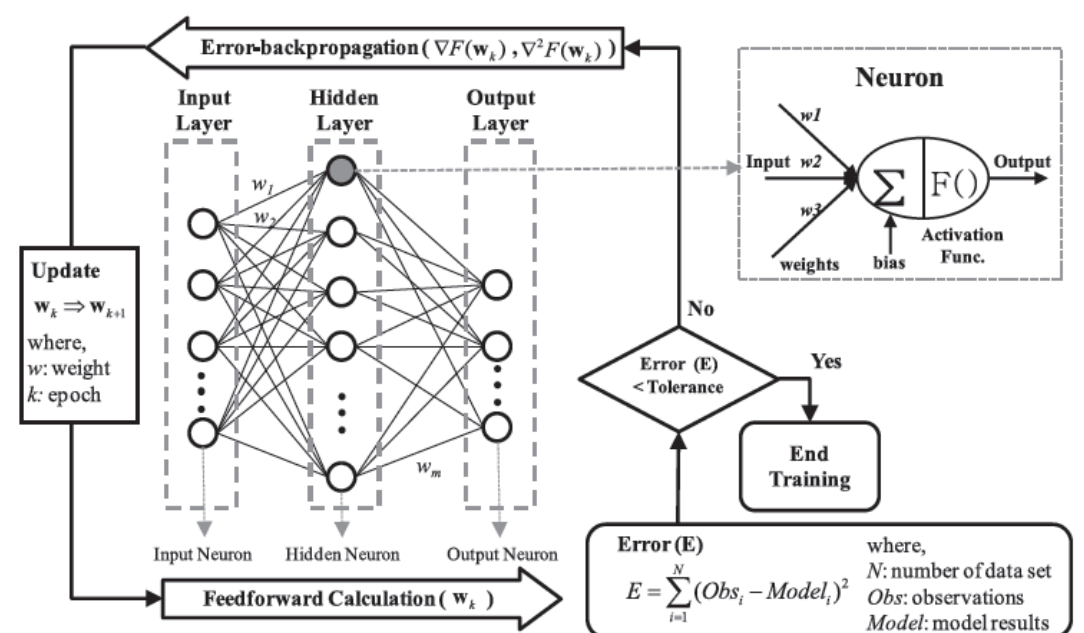
Figure 4. Schematic diagram of backpropagation training algorithm and typical neuron model